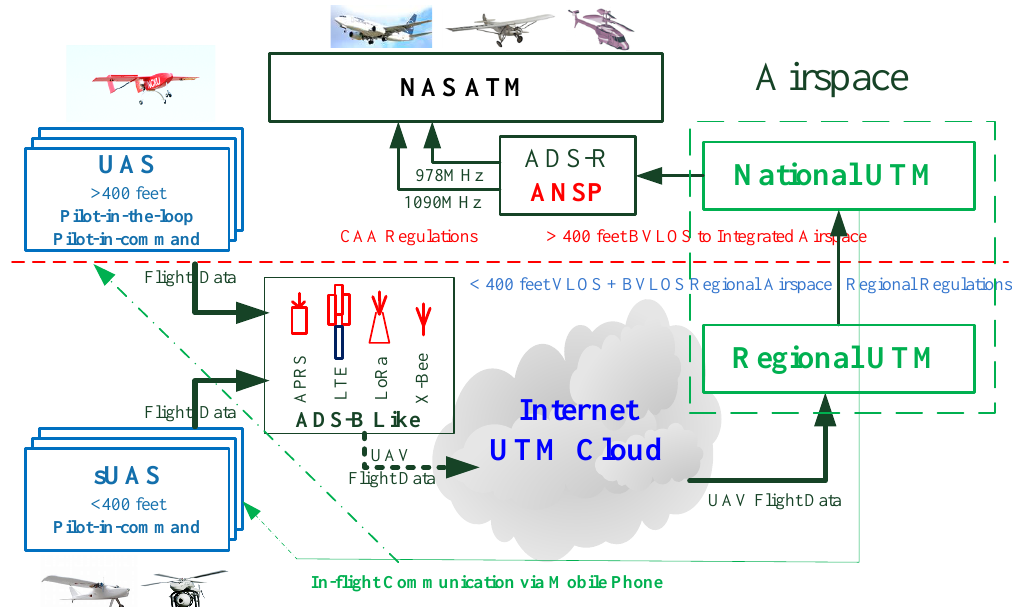
Figure2. The hierarchical unmannedaircraft system(UAS) tra ffi c management(UTM) inTaiwan Figure 2. The hierarchical unmanned aircraft system (UAS) traffic management (UTM) in Taiwan [10,29].